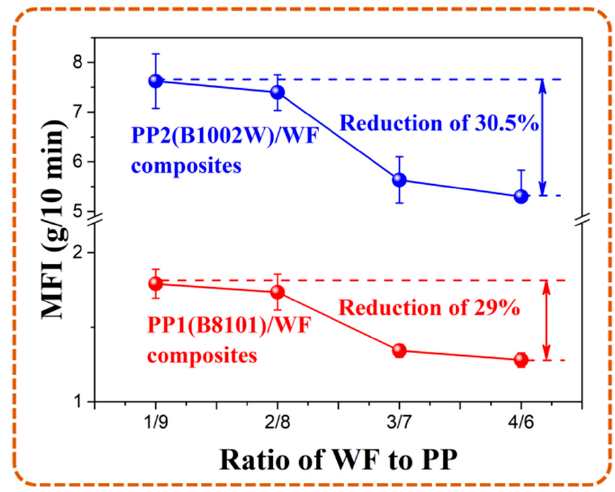
Figure 6. MFR of PP1 and PP2 based WPCs with different WF content.